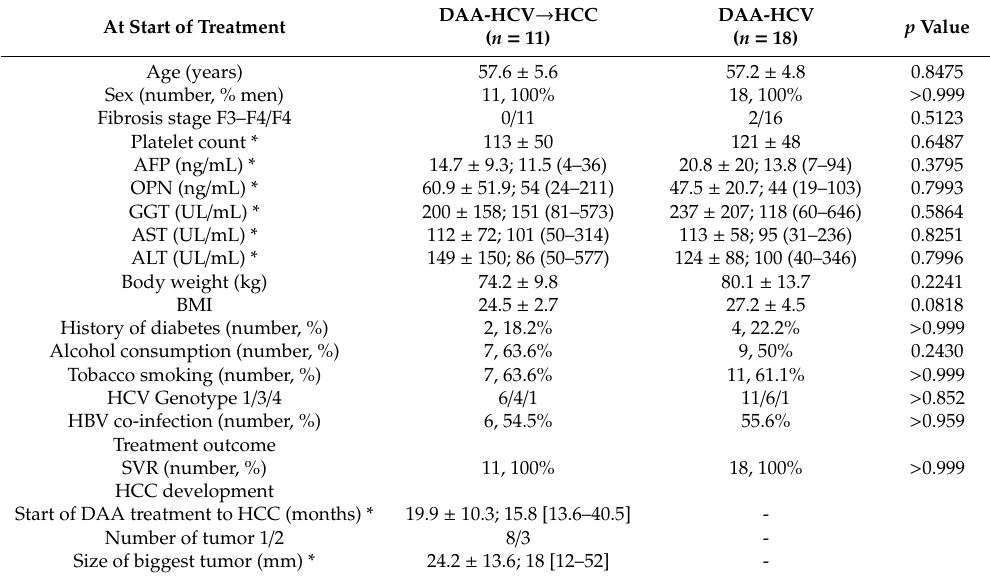
Table 1. Characteristics of HCV-infected patients treated by DAA.